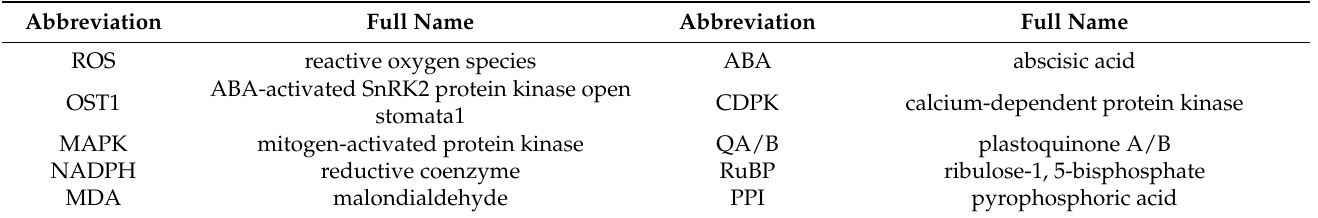
Table 1. Abbreviations and their full titles.